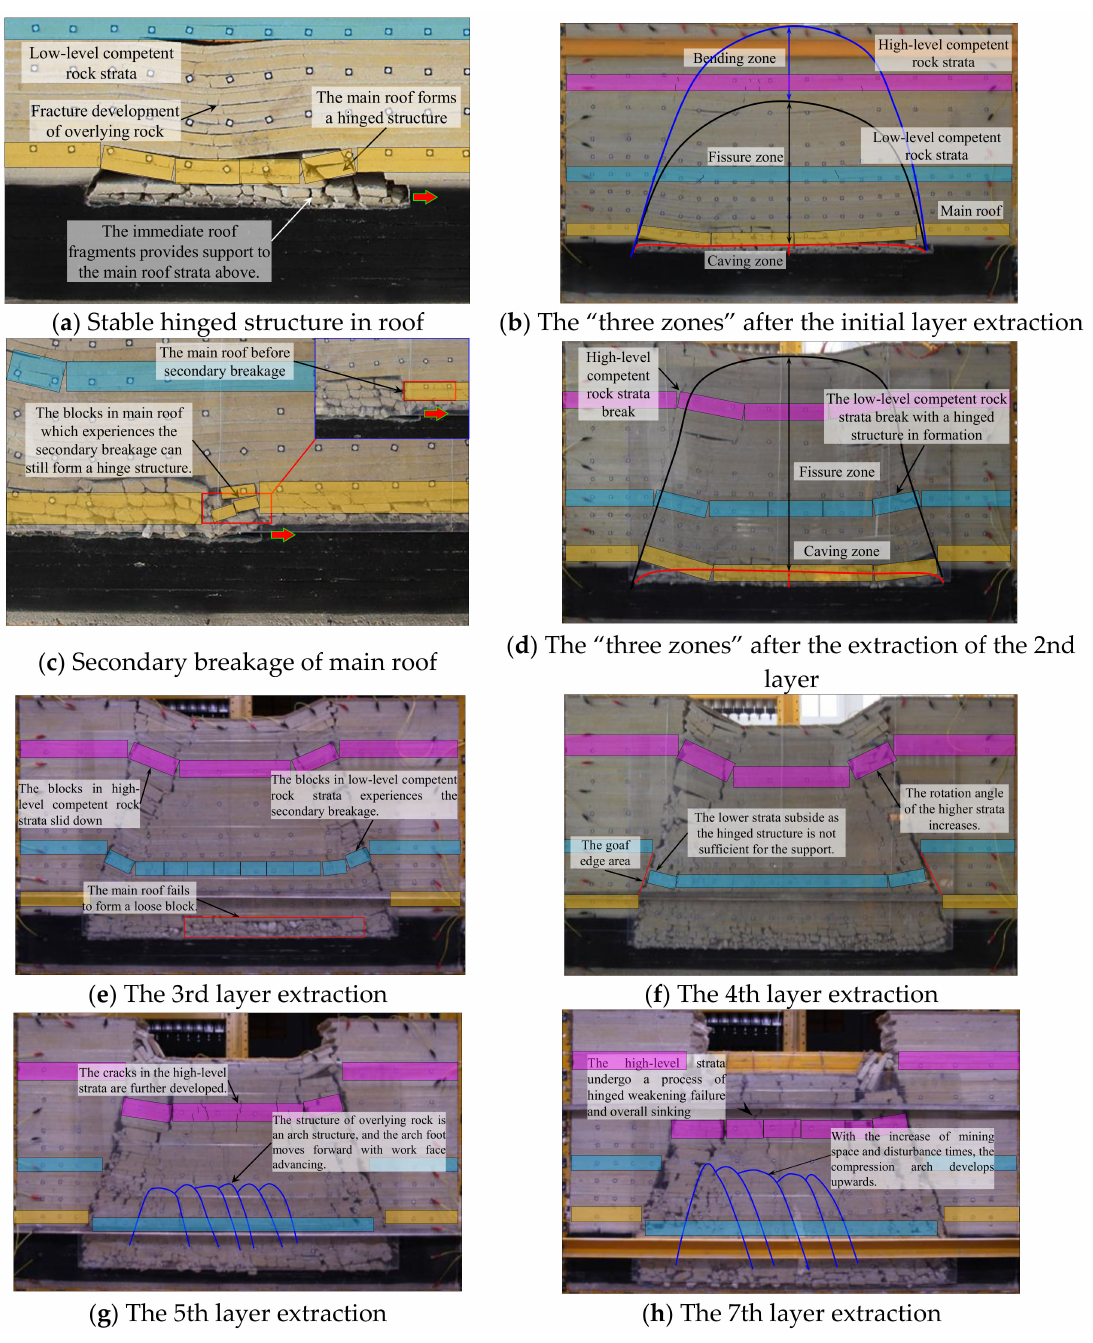
Figure 5. Overburden rock mass failure at different mining